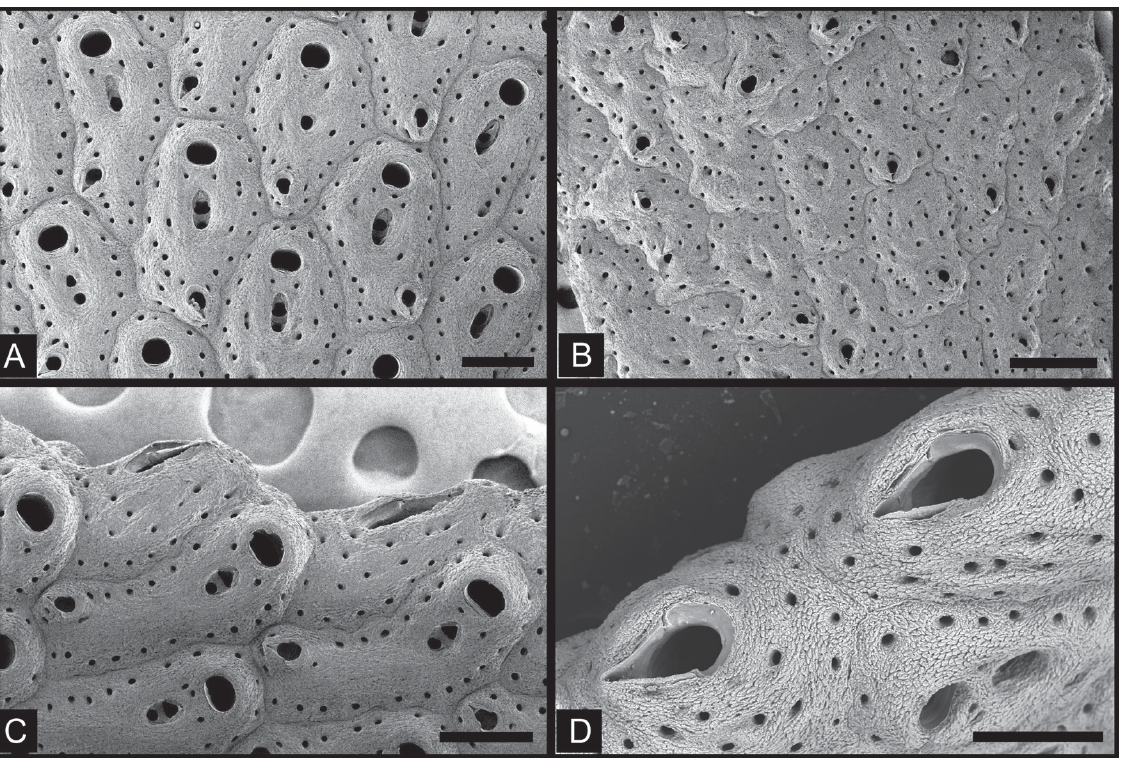
Fig. 15. Adeonellopsis parvirostrum sp. nov. A . Middle of branch, showing autozooids lacking suboral avicularium (NsMT-Te780). B . Kenozooids in old part of branch (NsMT-Te780). C . Autozooids and marginal vicarious avicularia at periphery of branch (NsMT-Te780). D . Lateral view of vicarious avicularium at branch bifurcation (NSMT-Te780). SEM images. Scale bars: A, C–D = 200 μm; B = 300